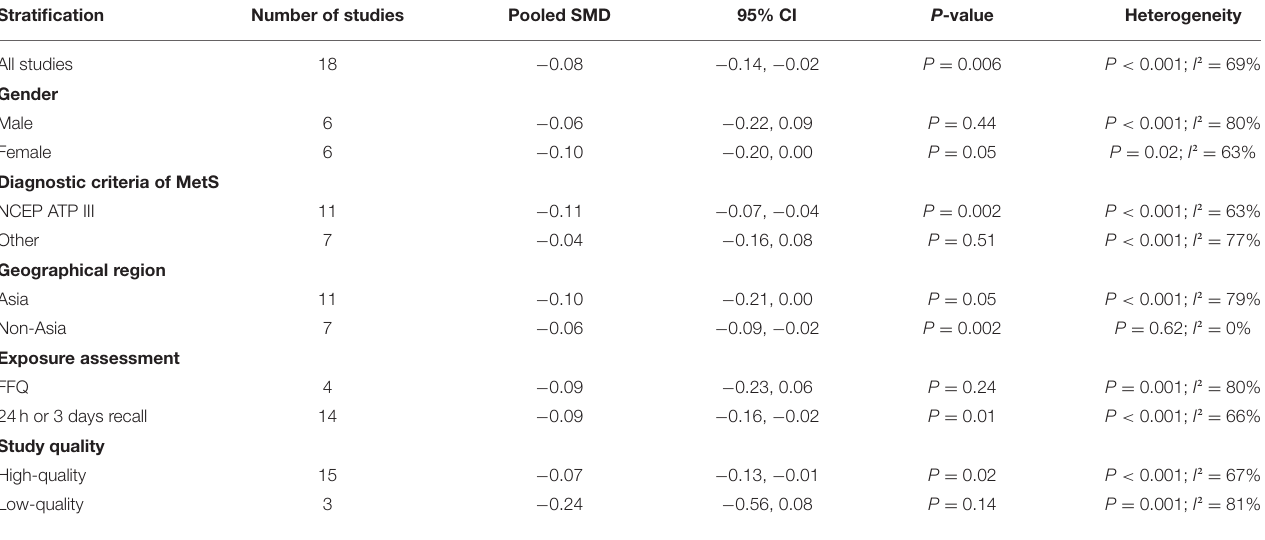
TABLE 3 | Subgroup analysis for SMD of dietary vitamin E level in MetS vs. control